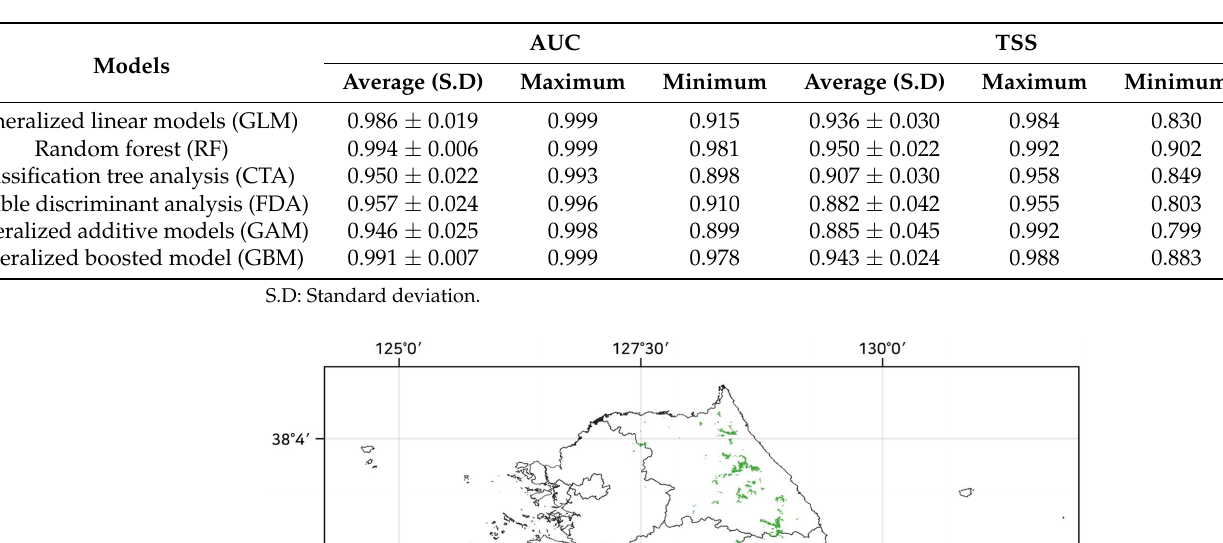
Table 3. Accuracy of the single-species distribution model based on mean, maximum, and mini- mum values.